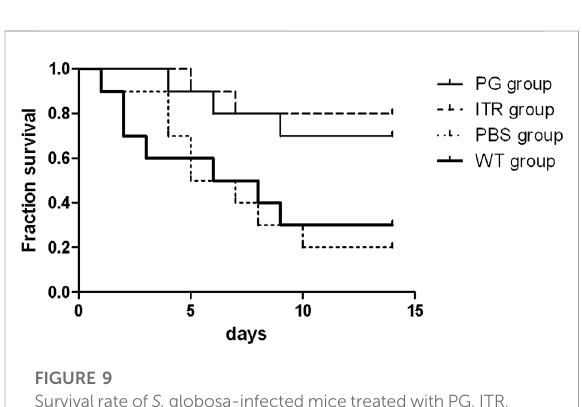
FIGURE 10 AST, ALT, BUN, and Cr levels after recombinant phage injection. AST, aspartate aminotransferase; ALT, alanine aminotransferase; BUN, blood urea nitrogen; Cr,